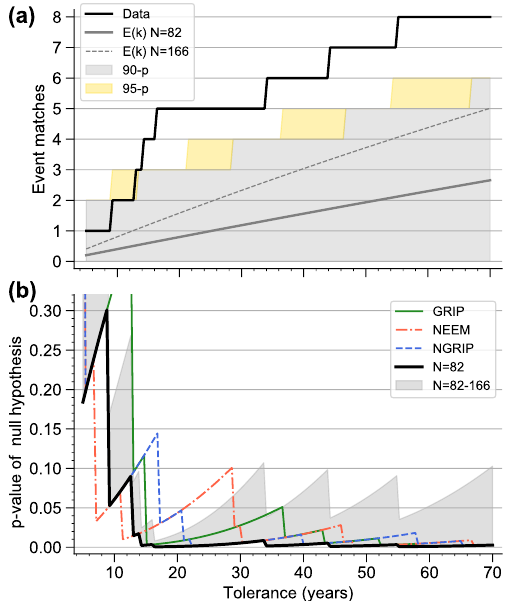
Figure 5. Probabilities of the observed number of DO events oc- curring shortly after volcanic eruptions under the null hypothesis. (a) Number of event matches for the stack onsets (data) as a func- tion of the tolerance compared to the expected value E [ k ] as well as 90% (90-p) and 95% (95-p) confidence bands of the null hypoth- esis. Here, the upper limit of the bands corresponds to the smallest number of matches that have a probability of strictly less than 10% (5%) according to Eq. (4). (b) Probability to observe at least as many event matches as in the data under the null hypothesis, calcu- lated from Eq. (4). These probabilities are the p values of the null hypothesis. The thick black line shows the results for the stack on- sets and the Poisson null hypothesis using λ = N/(cid:49)T , with N = 82 being the number of large eruptions in the investigated time inter- val. The gray shading indicates the range of probabilities when in- creasing N from N = 82 to N = 166. Results for the onsets from individual cores with N = 82 are also